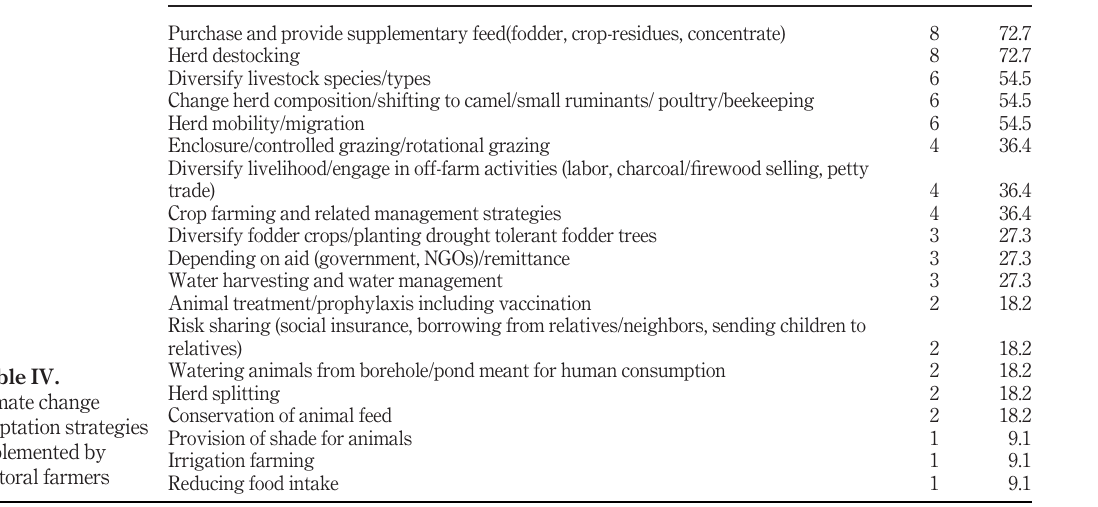
Table IV. Climate change adaptation strategies implemented by pastoral farmers